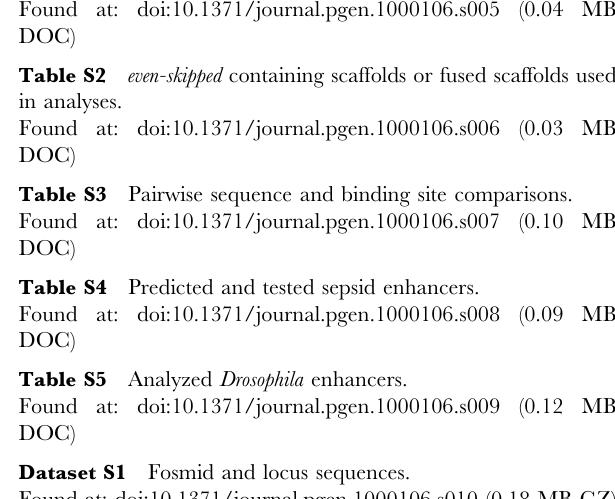
Table S1 Sequenced fosmids.